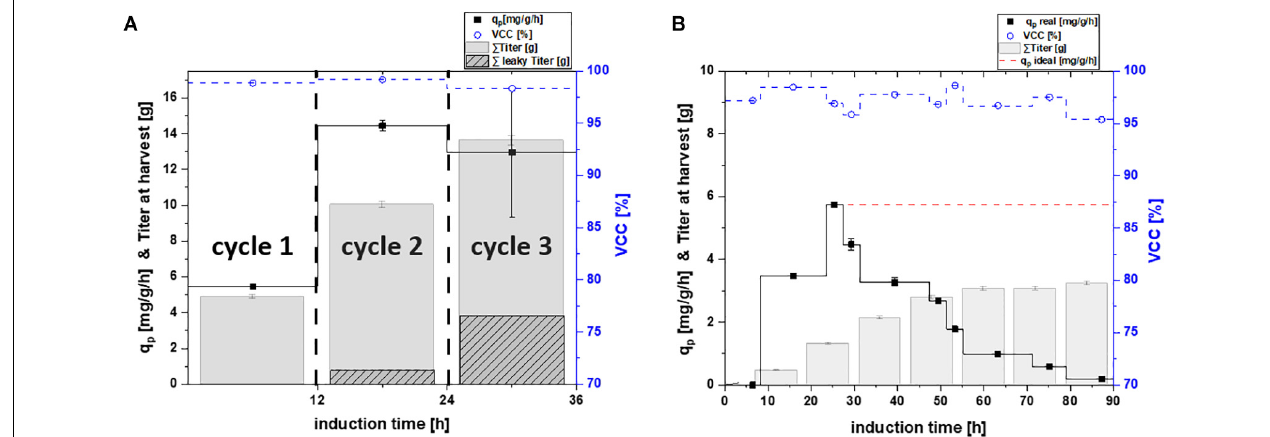
FIGURE 3 | Specific productivity q p (mg/g/h), viable cell concentration (=VCC) [%] and the titer available for harvest plotted for (A) repetitive fed-batch cultivation separated in their number of cycles; and (B) a chemostat process plotted as a function of induction time; theoretical ideal chemostat was simulated at q p , max .; as extracellular protein was found for cultivations of the periplasmic proteins, the secreted protein is shown in dotted lines for the harvested titer; VCC was evaluated by flow cytometry analysis with an average standard deviation of